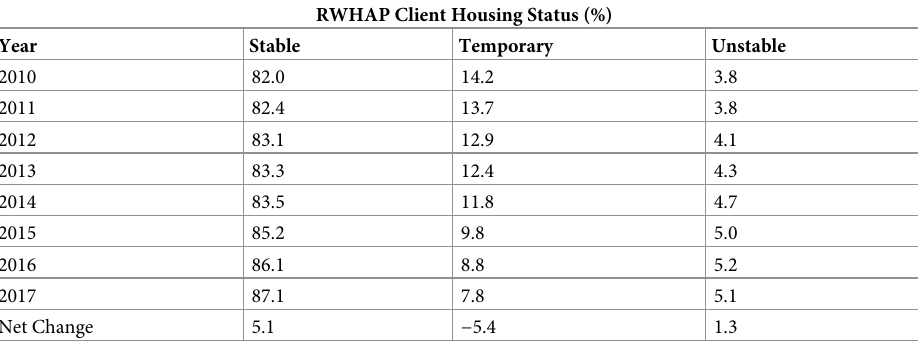
Table 1. RWHAP Services Report, clients by housing status, 2010–2017—US and 3 territories.